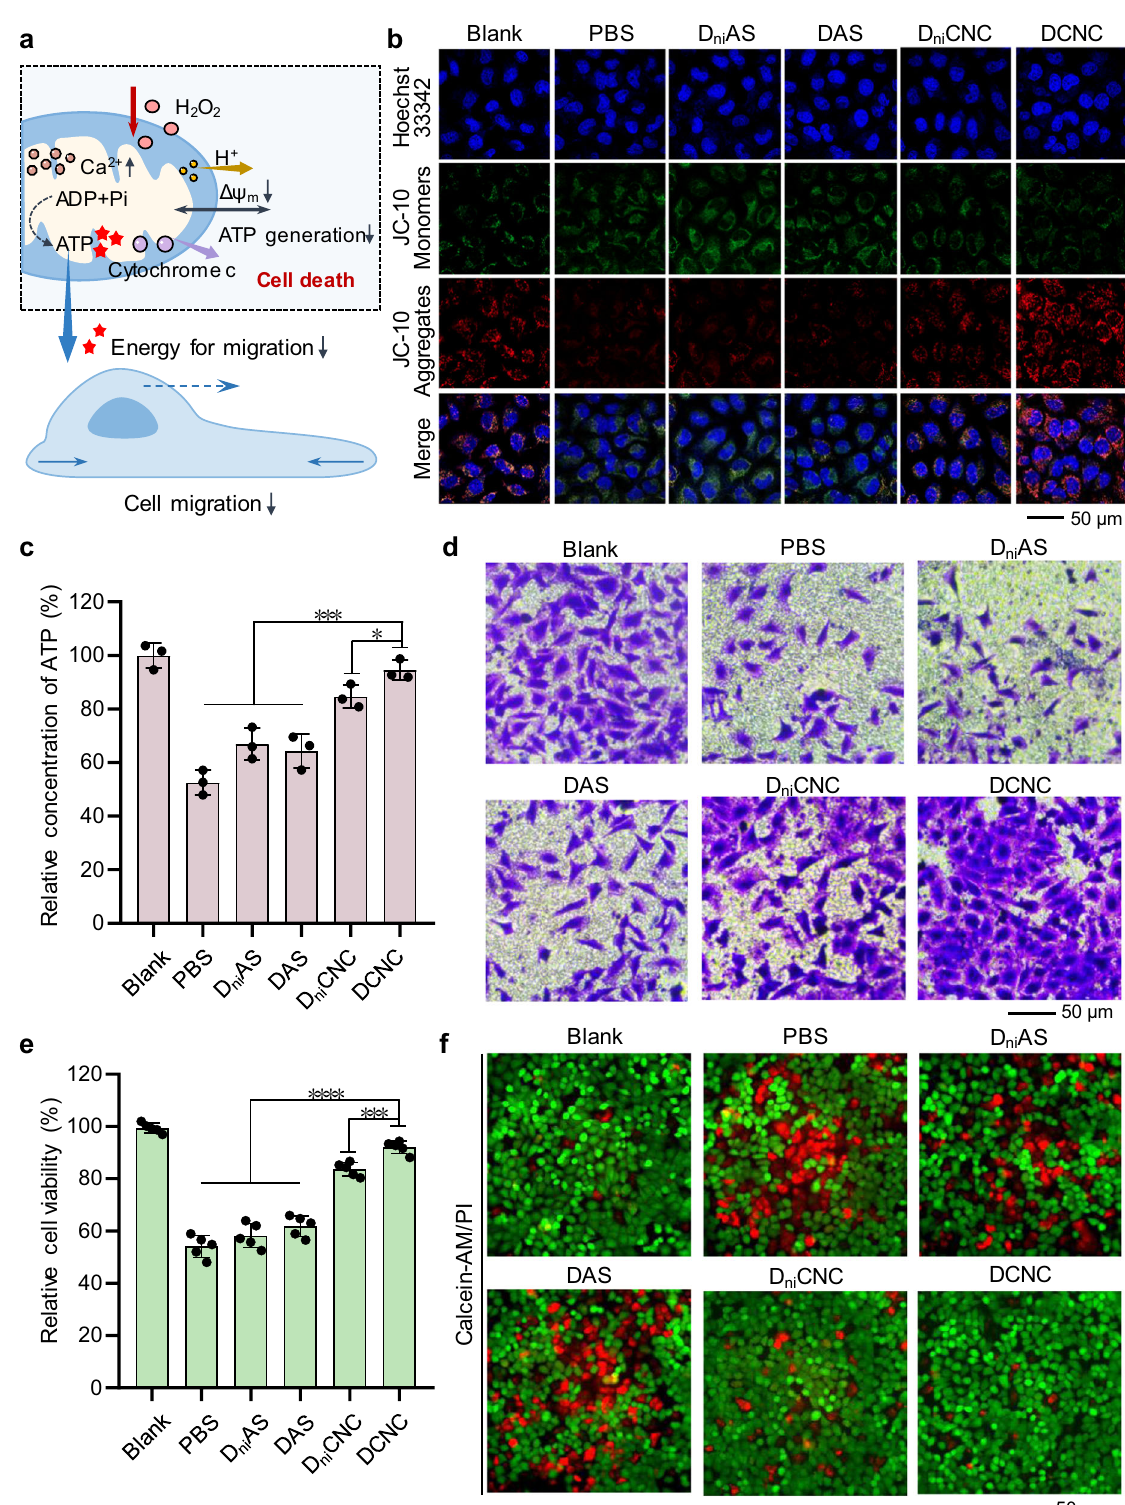
Fig. 6 | Preservation effects of DCNC towards cells. a Schematic illustration of mitochondria damage caused by high-concentration H 2 O 2 . b Representative fl uorescence microscopy images showing the JC-10-staining MCF-7 cells after incubation with DCNC for different time and then treated with H 2 O 2 . c Relative concentration of intracellular ATP. Bars represent mean±SD ( n =3 independent samples). (* P <0.05; *** P <0.001, calculated by two-tailed unpaired t test). d Representative microscopy images of MCF-7 cells treated with a series of mate- rials in a Transwell cell invasion device. e Cell viability of MCF-7 cells after